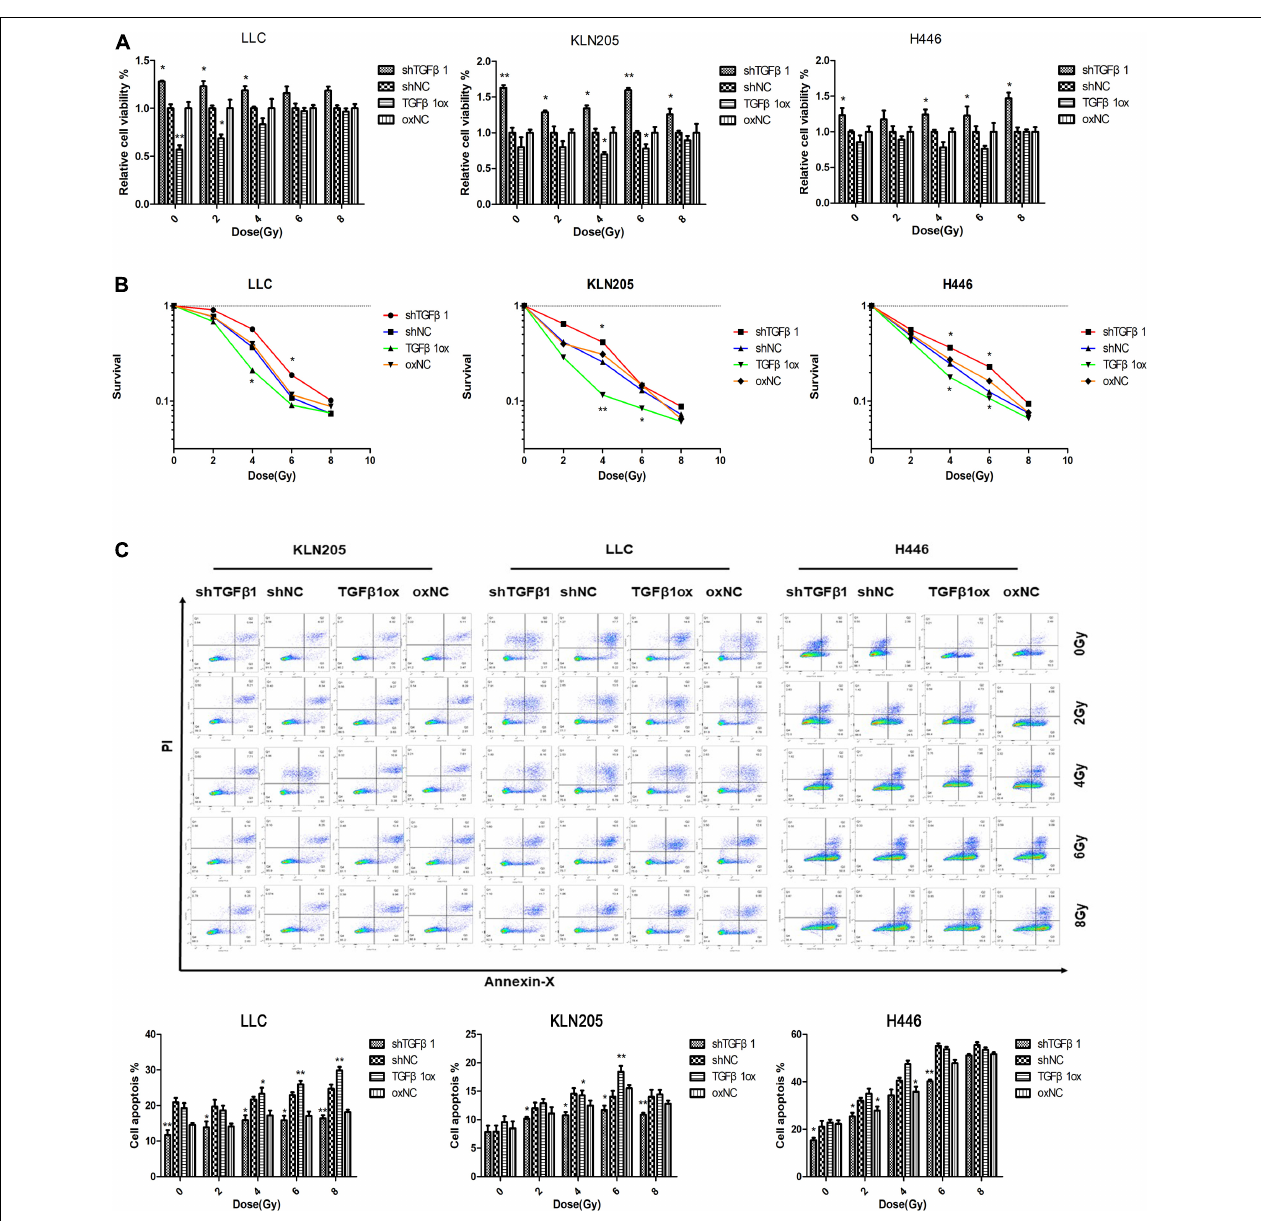
FIGURE 4 | TGF β 1 level produced by CAFs affected the radiosensitivity of lung cancer cells. (A,B) CAFs with TGF β 1 knocked down inhibited the radiosensitivity of lung cancer cells after radiotherapy of 0, 2, 4, 6, or 8 Gy detected by CCK-8 assay and clonogenic survival assay, CAFs with TGF β 1 overexpression enhanced the radiosensitivity of lung cancer cells. (C) TGF β 1-knocked down CAF inhibited the apoptosis of tumor cells after radiotherapy and the apoptosis of tumor cells were induced after co-cultured with TGF β 1 overexpression CAFs. Cell apoptosis rate was examined by Annexin V/PI staining and flow cytometry assays. Statistical significance is shown (* p < 0.05; ** p < 0.01). shNC and oxNC, control groups corresponding to knockdown and overexpression of TGF β 1 recombinant lentiviral infection; shTGF β 1 and TGF β 1ox, knockdown and overexpression of TGF β 1 recombinant lentiviral infection; LLC, Lewis lung cancer cell; KLN205, mouse